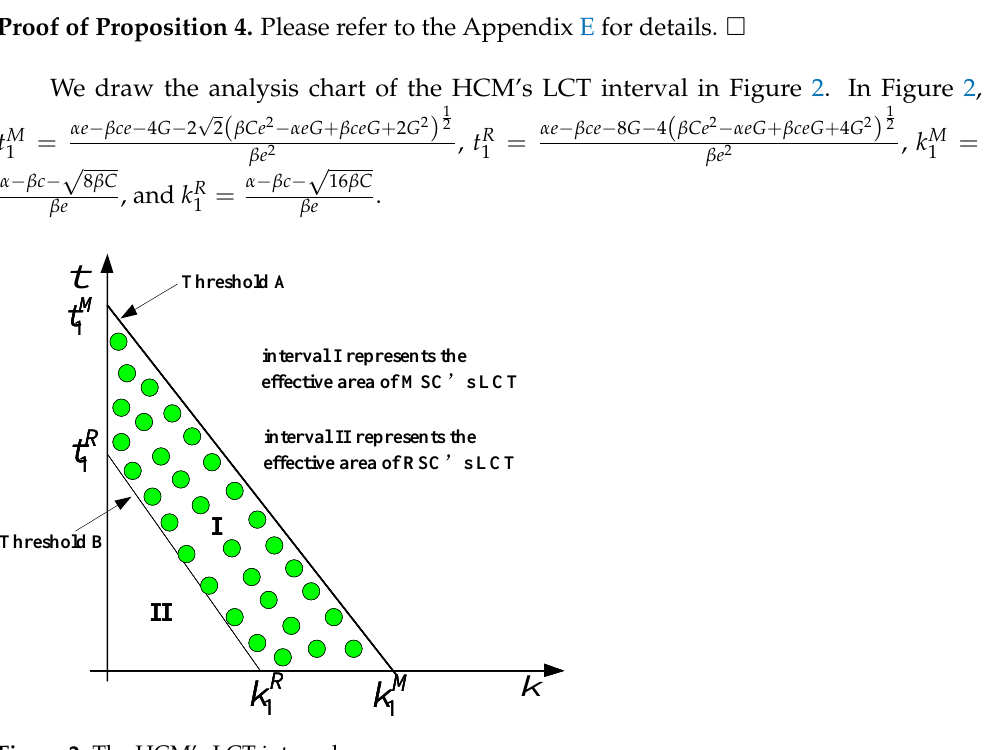
Figure 2. The HCM’s LCT interval.